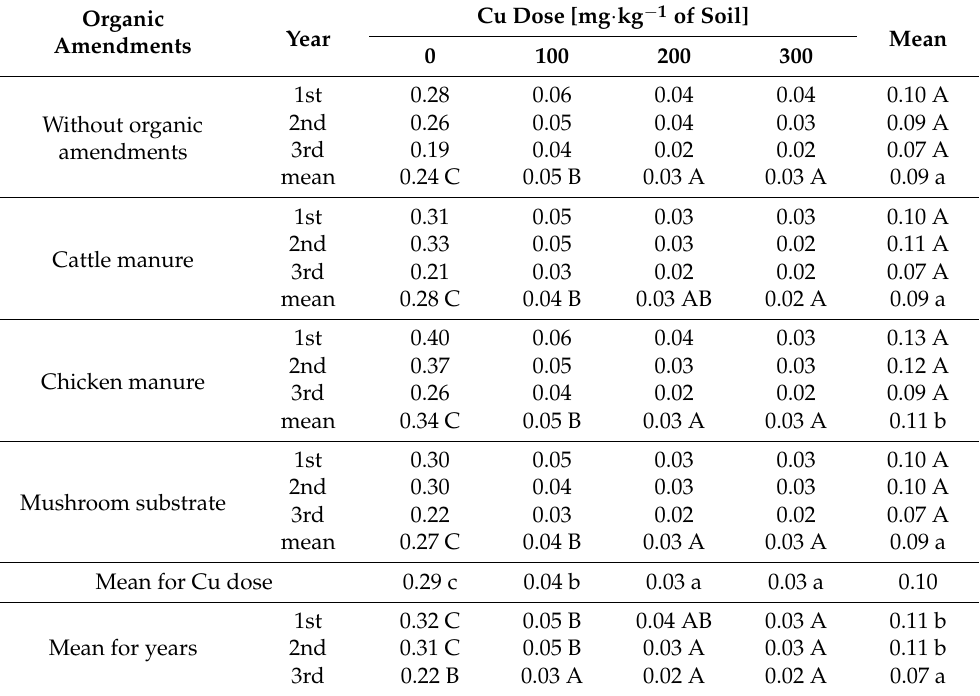
Table 9. Copper bioaccumulation factor in